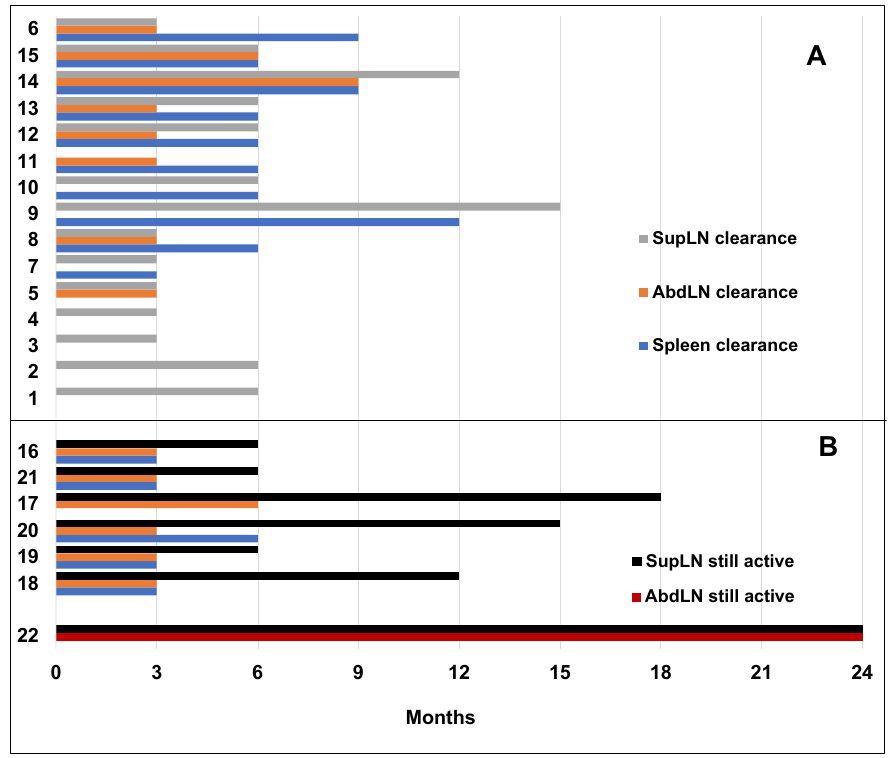
Figure 4. Plot of AbdLNs and SupLNs achieving CR or still diseased, and splenic response in 22 patients examined. ( A ) Patients who achieve CR (AbdLNs, SupLNs and splenic CR). ( B ) Lymphnodal and splenic US response in patients in PR and in the patient in SD. In patients in PR, although AbdLNs and splenic response achieved a CR, SupLNs were still diseased by CLL. Patient 22 was in SD at T24 and both AbdLNs and SupLNs were still involved by CLL.